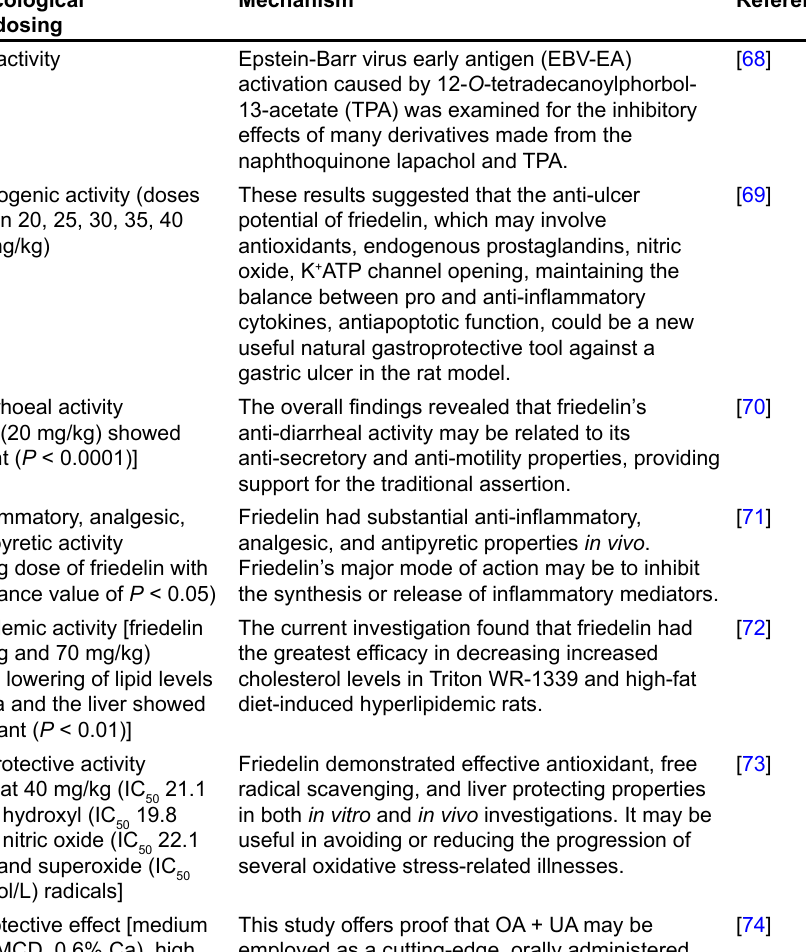
Table 2. Pharmacological activity of phytoconstituents of FA ( continued